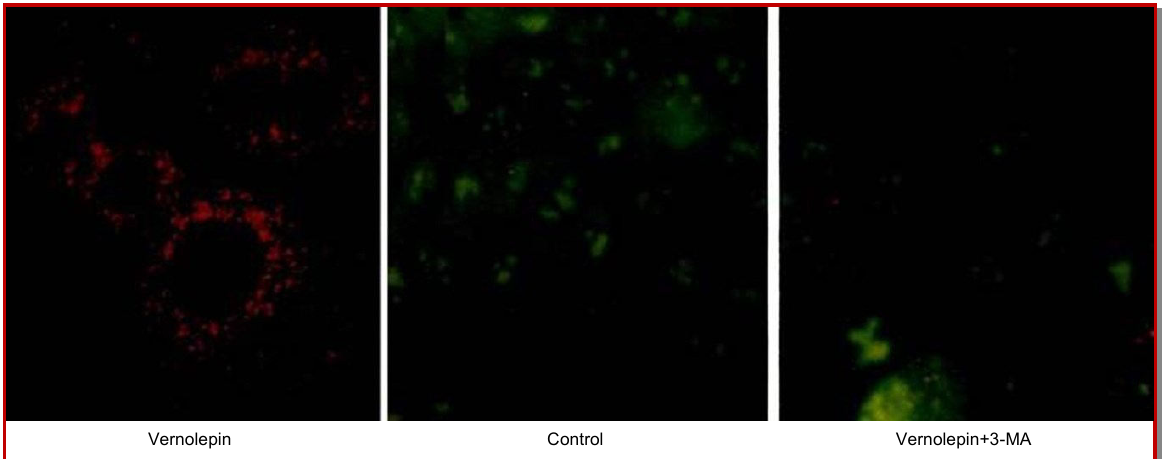
Figure 2 : Formation of autophagosomes was induced by vernolepin in ovarian cancer cells. OVCAR-3 (A); and SK-OV3 (B) cells were treated with vernolepin (30 μ M) or DMSO